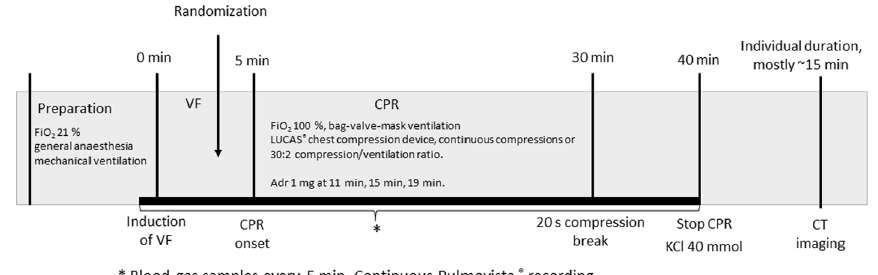
Fig. 1 Timeline of the experimental protocol. Adr: adrenaline; FiO 2 : fraction of inhaled oxygen; VF: ventricular fibrillation; CPR: cardiopulmonary resuscitation; KCl: potassium chloride; CT: computed